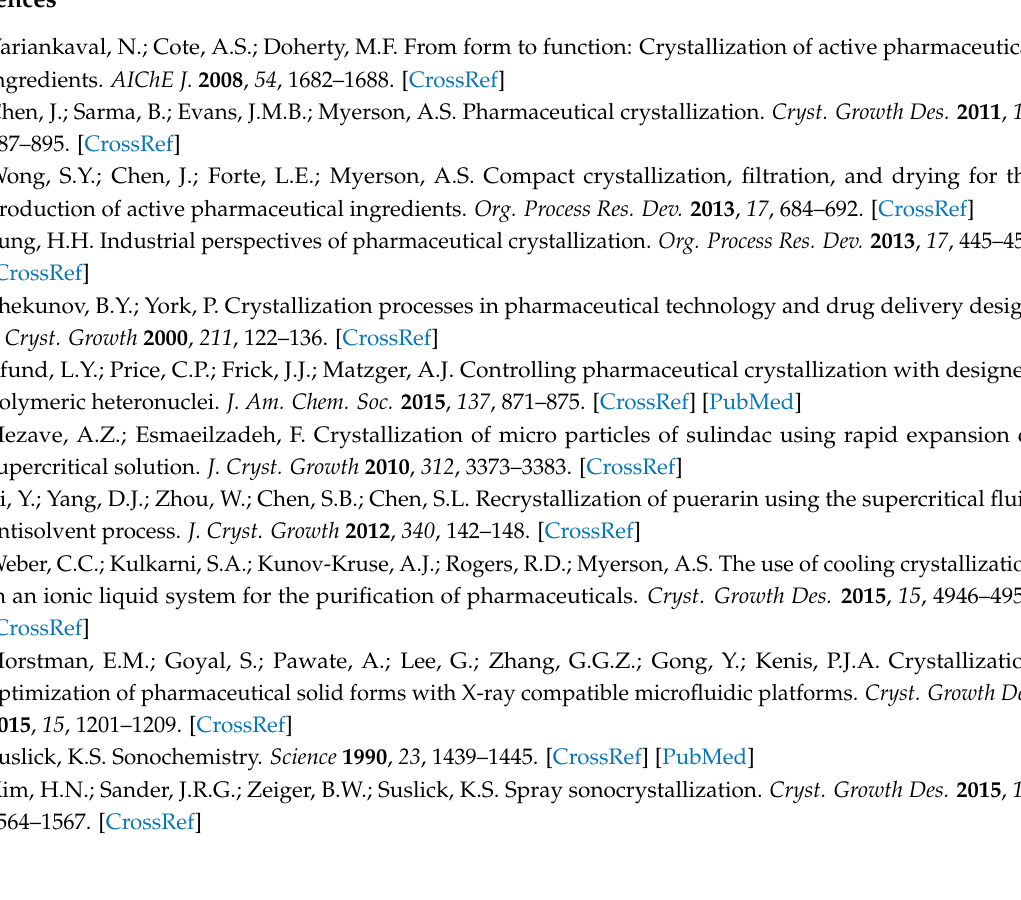
s1, Figure S1: Particle size distribution of sonocrystallized salicylamide crystals from Experiment 3 and sonocrystallized N’ -(propan-2-ylidene)-isonicotinohydrazide crystals from Experiment 14. Figure S2: NMR results of the synthesized N’ -(propan-2-ylidene)-isonicotinohydrazide crystals. Figure S3: Calculated PXRD pattern of N’ -(propan-2-ylidene)-isonicotinohydrazide from The Cambridge Crystallographic Data Centre (CCDC number: 706025). Figure S4: FTIR spectrum of N’ -(propan-2-ylidene)-isonicotinohydrazide from SpectraBase